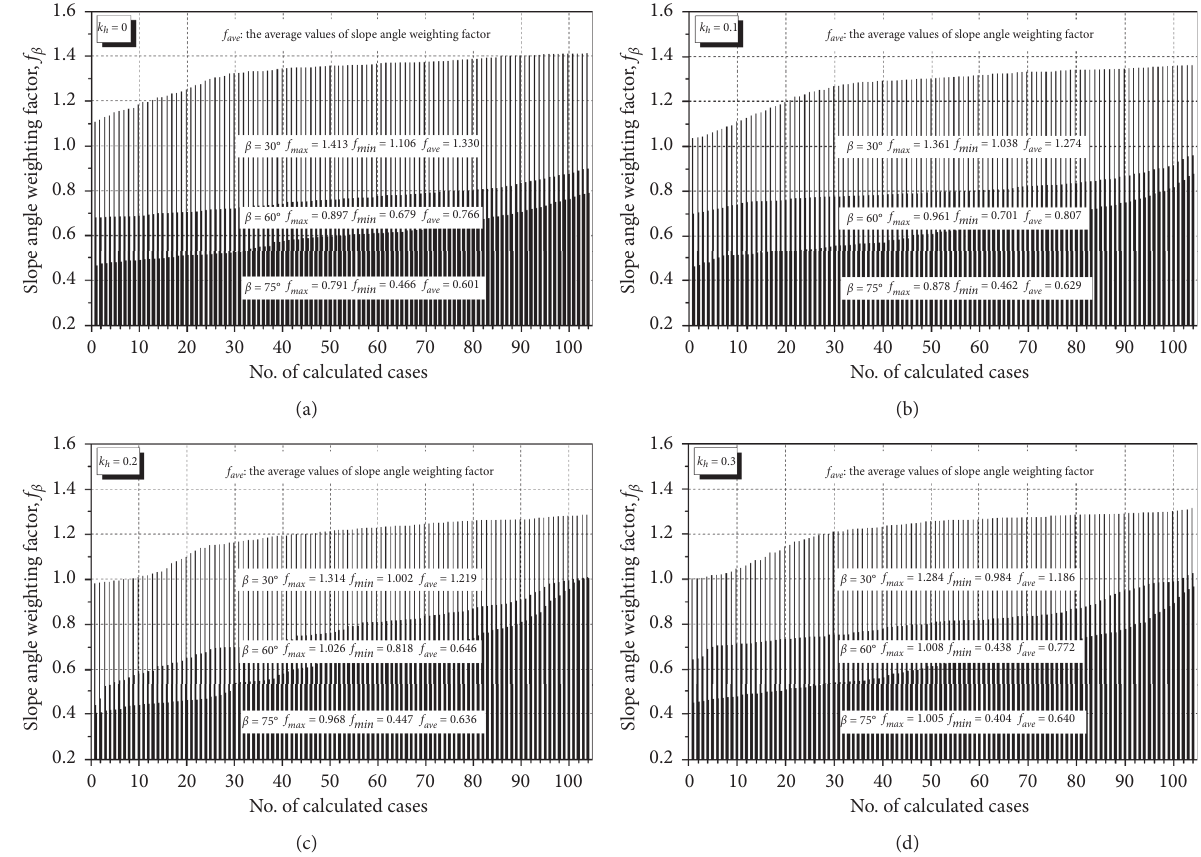
Figure 10: The slope angle weighting factors: (a) k